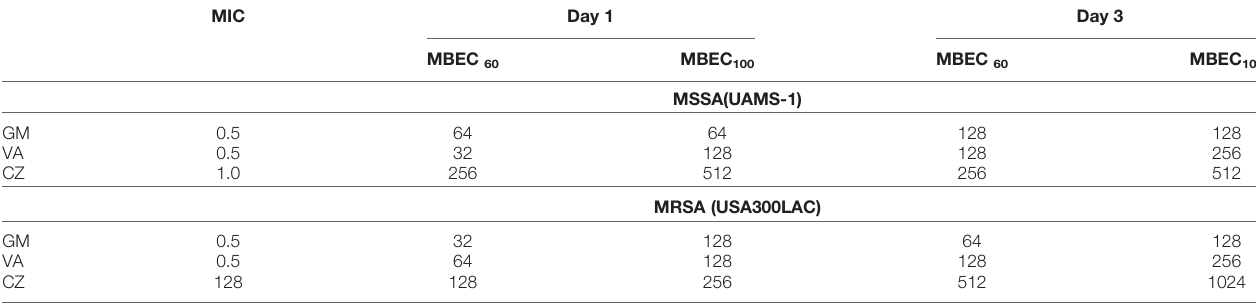
TABLE 1 | MIC and MBEC on bacteria in in vitro bio fi lm formed on a screw ( in vitro MBEC).